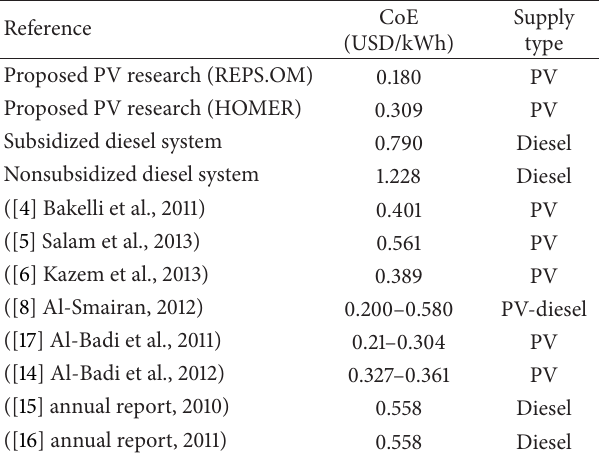
Table 7: Systems cost of energy